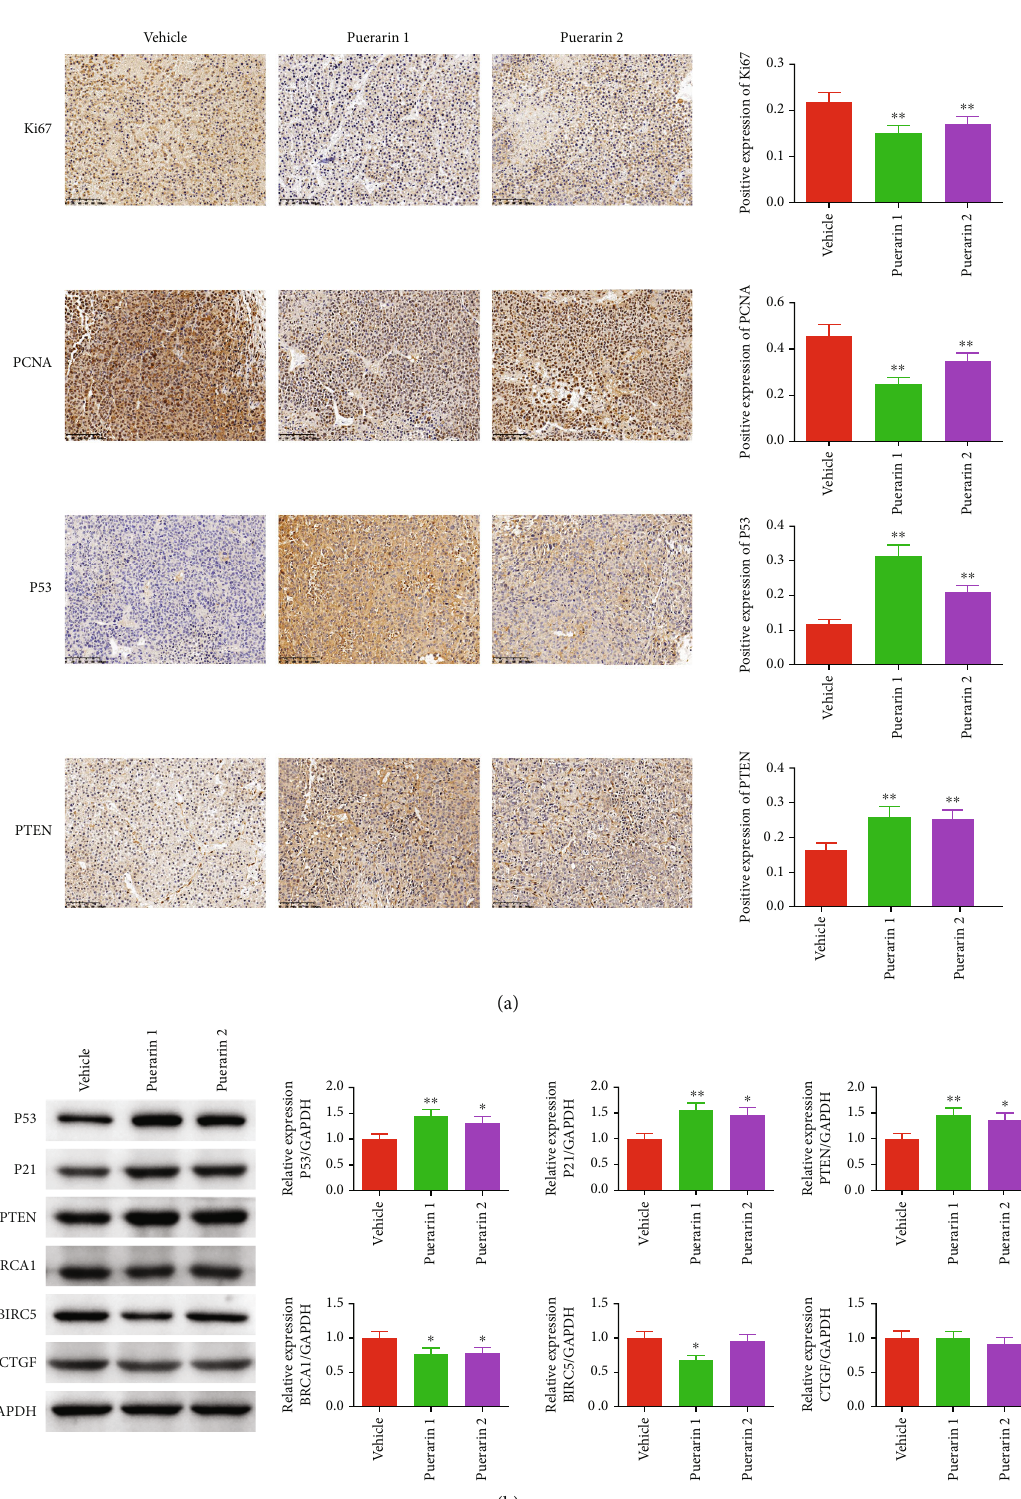
Figure 5: Expression of cell proliferation and tumor suppressor genes was regulated by puerarin treatment in OC model rats. (a) Positive expression of Ki67, PCNA, P53, and PTEN in tumor tissues was detected by an immunohistochemistry assay (magni fi cation: × 200). (b) Protein expression levels of P53, P21, PTEN, BRCA1, BIRC5, and CTGF in tumor tissues were detected by Western blot assay, and GAPDH was used as the internal control. OC: ovarian